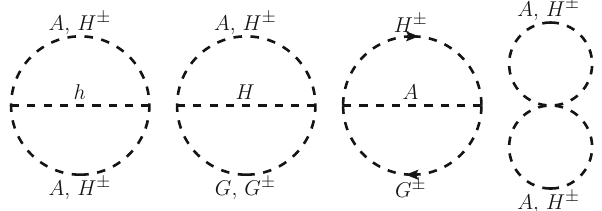
Fig. 5 Diagrams contributing at leading two-loop order to the IDM effective potential